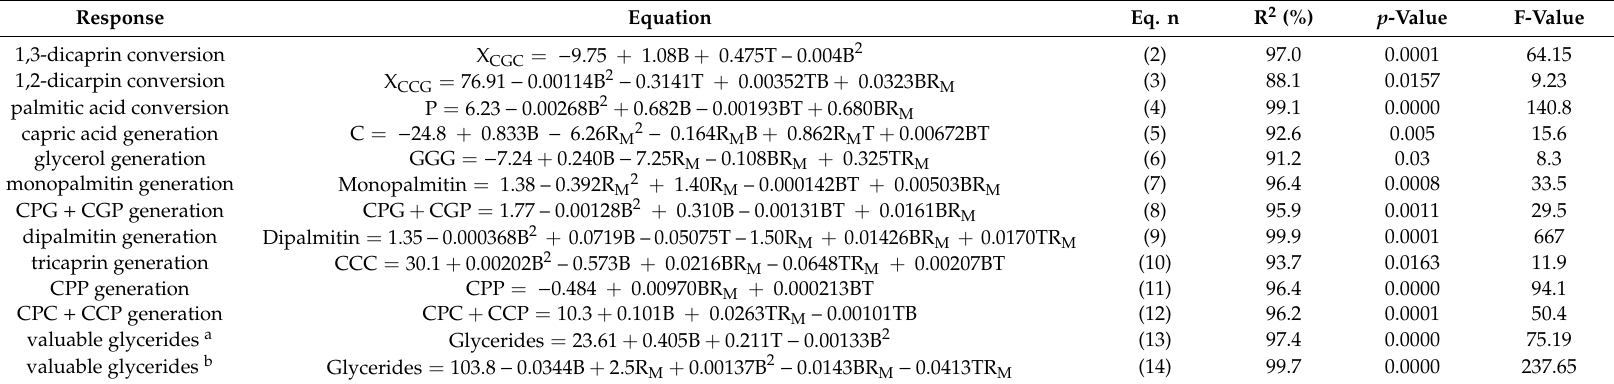
Table 5. Results of the models obtained with the Statgraphics Centurion XV software for each of the responses studied in the dicaprin and palmitic acid esterification catalyzed by BCL / chitosan. All data had a confidence level greater than